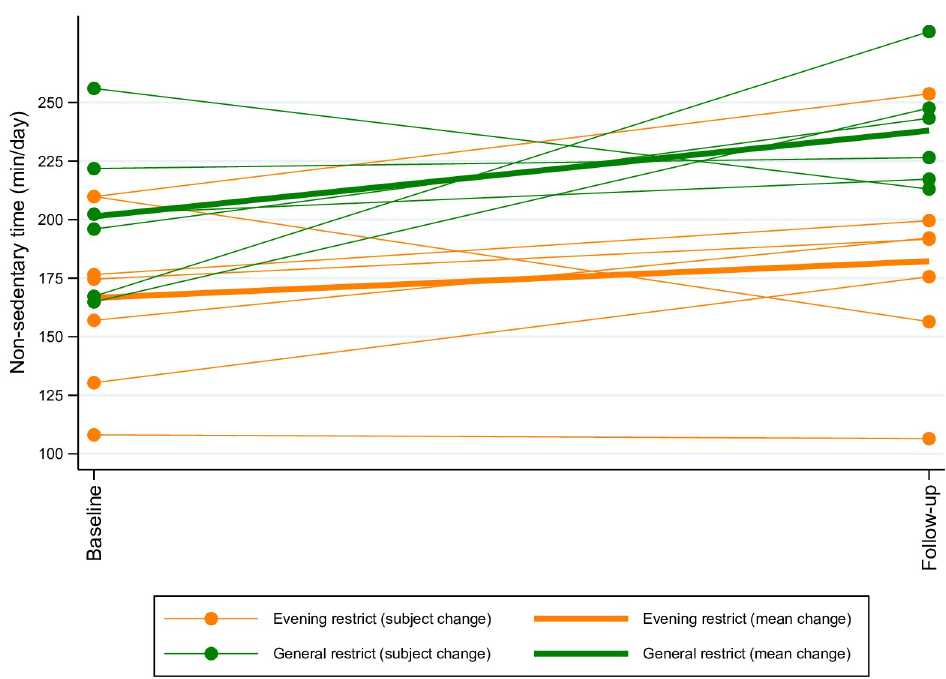
Fig 4. The potential of two screen media reduction interventions on change in non-sedentary time (min/day) in children six-to-ten years of age. The figure above illustrates the change in non-sedentary time (min/day) for children six-to-ten years of age. The data is parsed based on group allocation (Evening Restrict group: orange, General Restrict group: green). A thick best fit line for each group has been added to display direction of change in mean non-sedentary time from baseline to